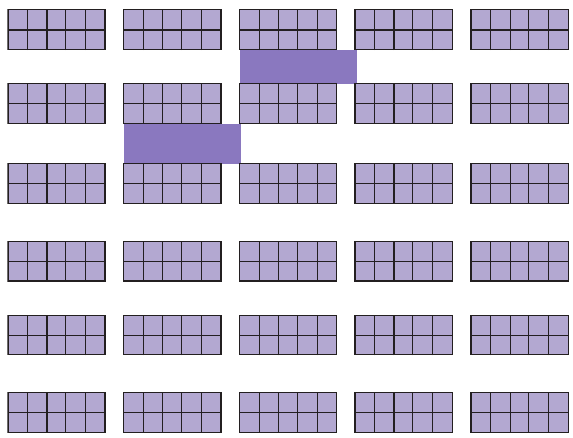
Figure 8: Blockage map.